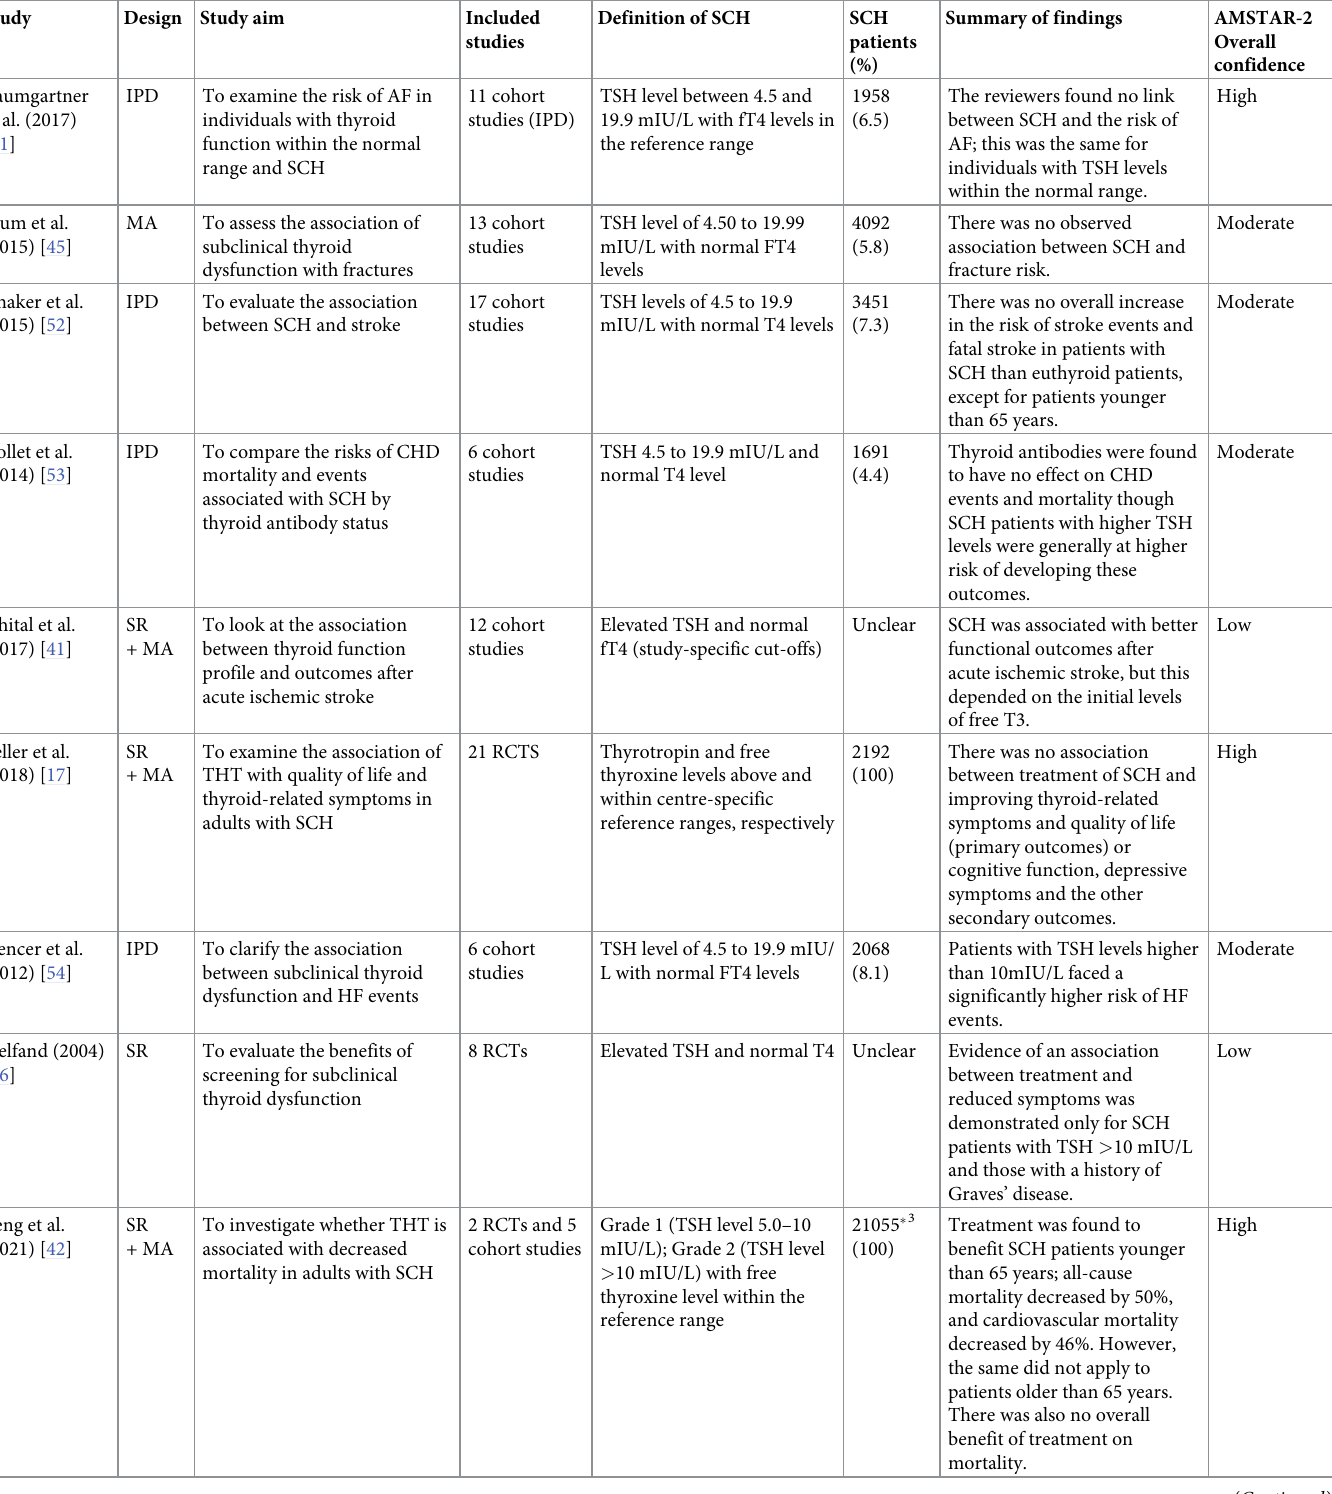
Table 2. Characteristics of the included systematic reviews and